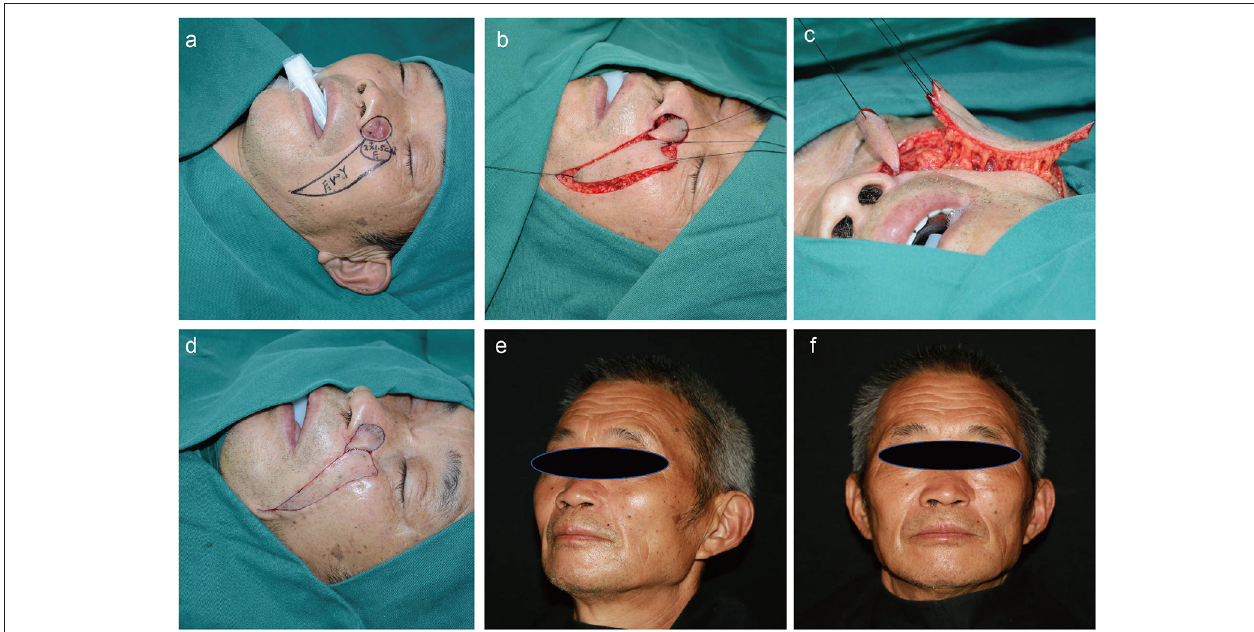
FIGURE 4 | A 70-year-old man with a history of basal cell carcinoma on the left ala for 1 year. Application of the sequential flap in a third patient. (a) Preoperative design. (b,c) Dissection of the round rotational flap and V–Y advancement island pedicle flap. (d) Flaps are sutured into the defect using a dermal suture with 5–0 absorbable sutures. (e,f) Appearance at 17 months after the